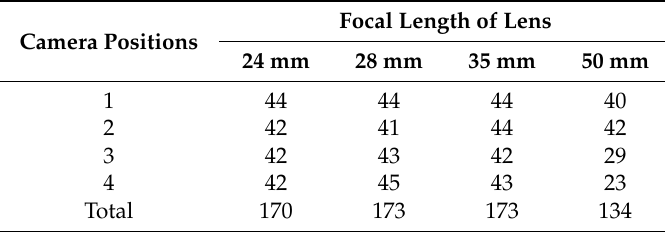
Table 1. The number of images taken by different lenses.